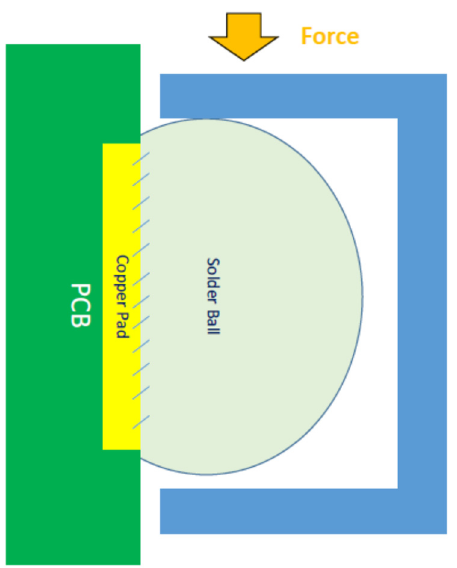
Figure 3. Schematic illustration of the Instron 5948 Micro-Mechanical device.